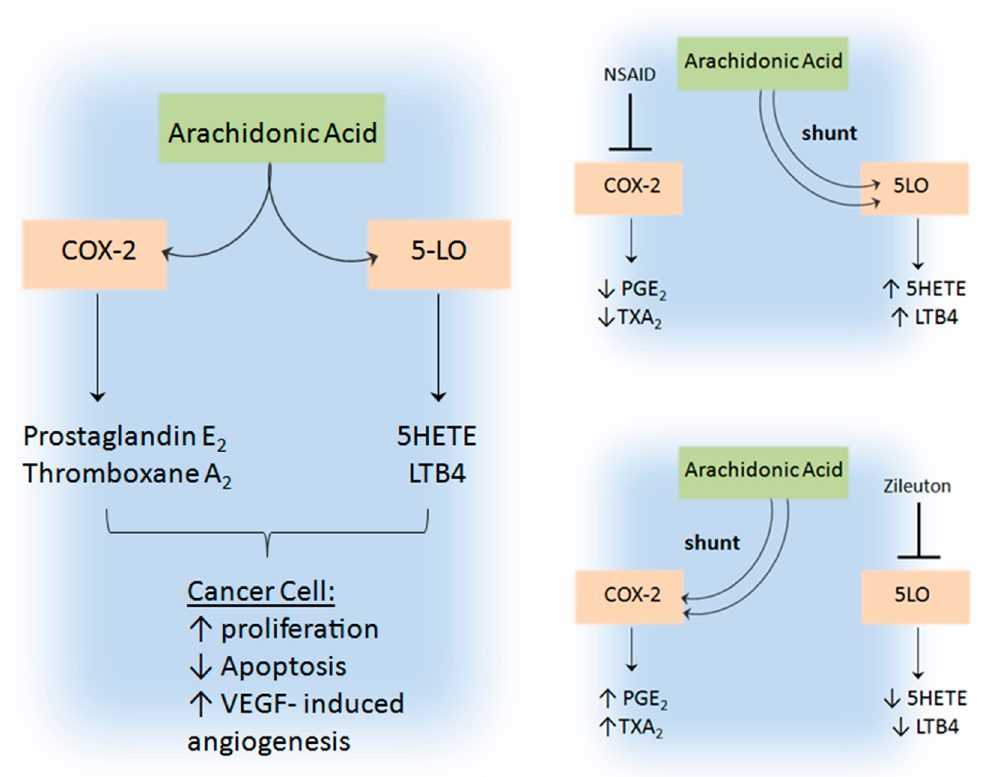
Figure 4. Pharmacological inhibition of the cyclooxygenase-2 signalling pathway results in a shunting of arachidonic acid to the 5-lipoxygenase pathway or vice versa.